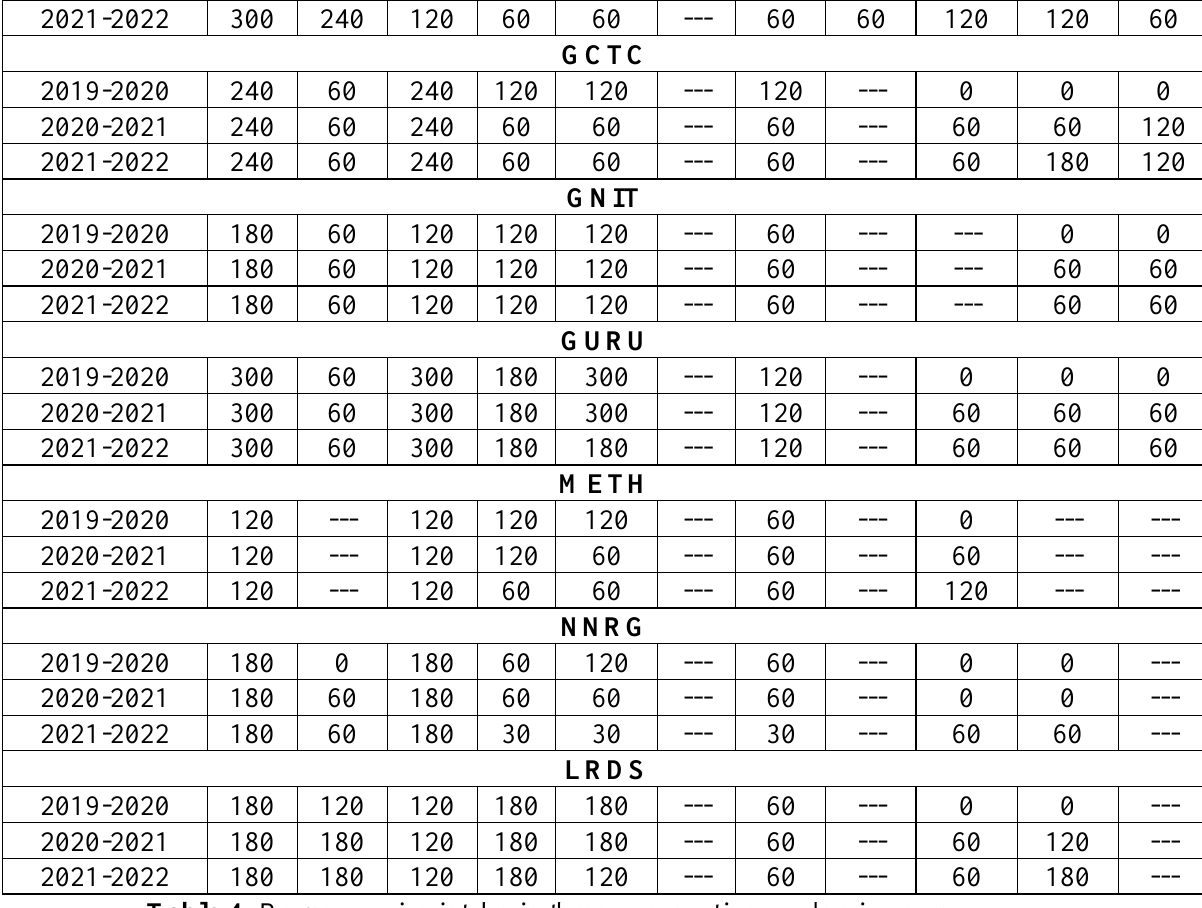
Table 4: Program-wise intake in three consecutive academic years